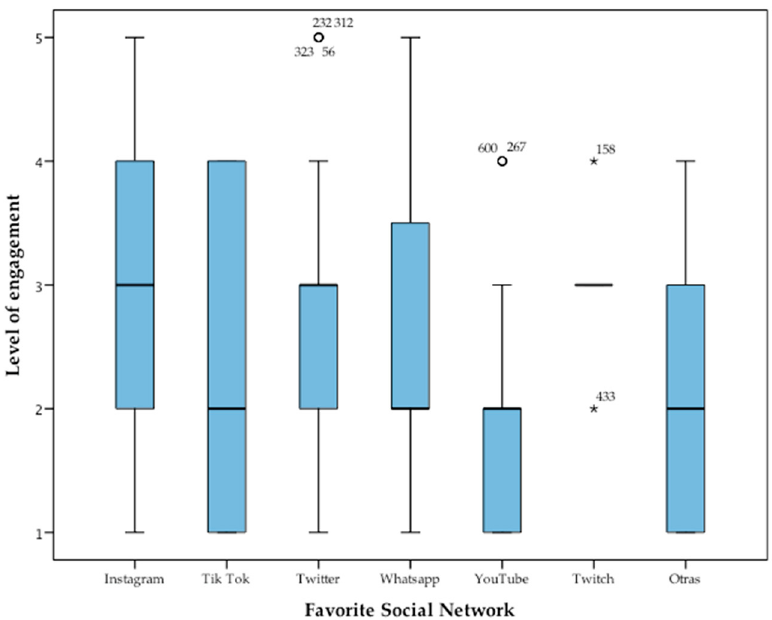
Figure 5. Boxplot for distribution of favorite social network and level of engagement in social networks. Own elaboration. Small circles and star values are outliers. Small circles, “out values”, and star ones, “far out values”.